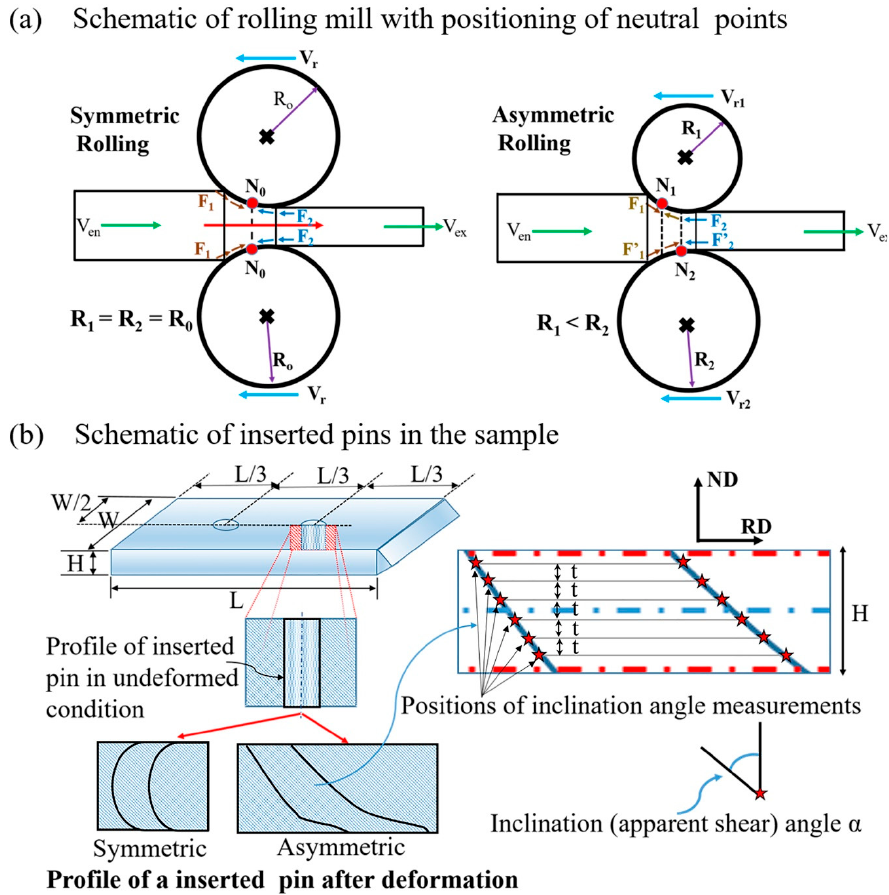
Figure 1. Schematic of the experimental setup, representing positons of ( a ) neutral points and ( b ) inserted pins in a sample.